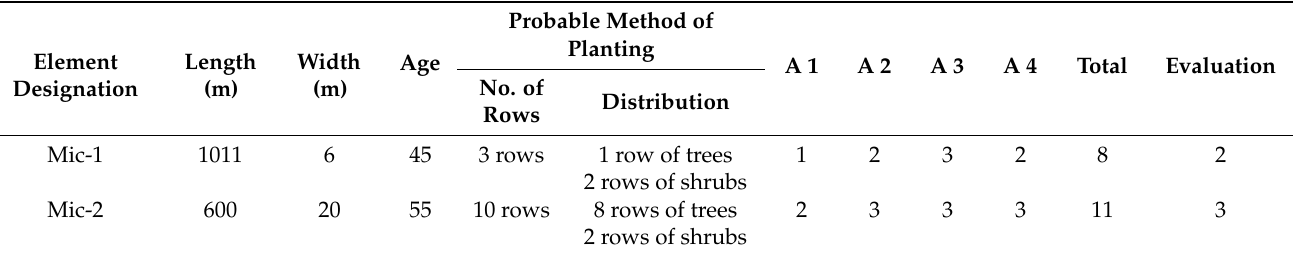
Table 7. Example of the evaluation of two windbreaks in study locality Micmanice.